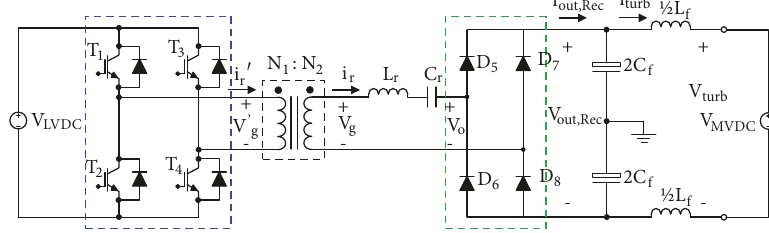
Figure 2: Circuit topology of series resonant converter (SRC#).